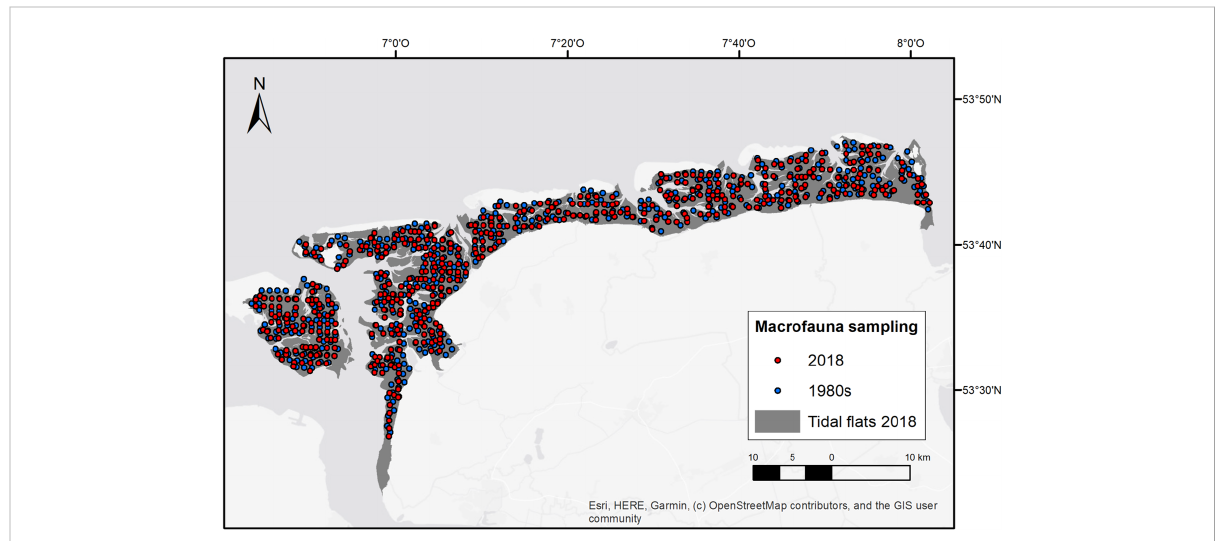
FIGURE 2 Sampled macrofauna data used for the long-term community analysis, sampling campaigns: SIBES 2018 (n=480) and SENSI1 1980s (n=480), plotted on the tidal fl at shape fi le for 2018 (Rijkswaterstaat RWS, Royal